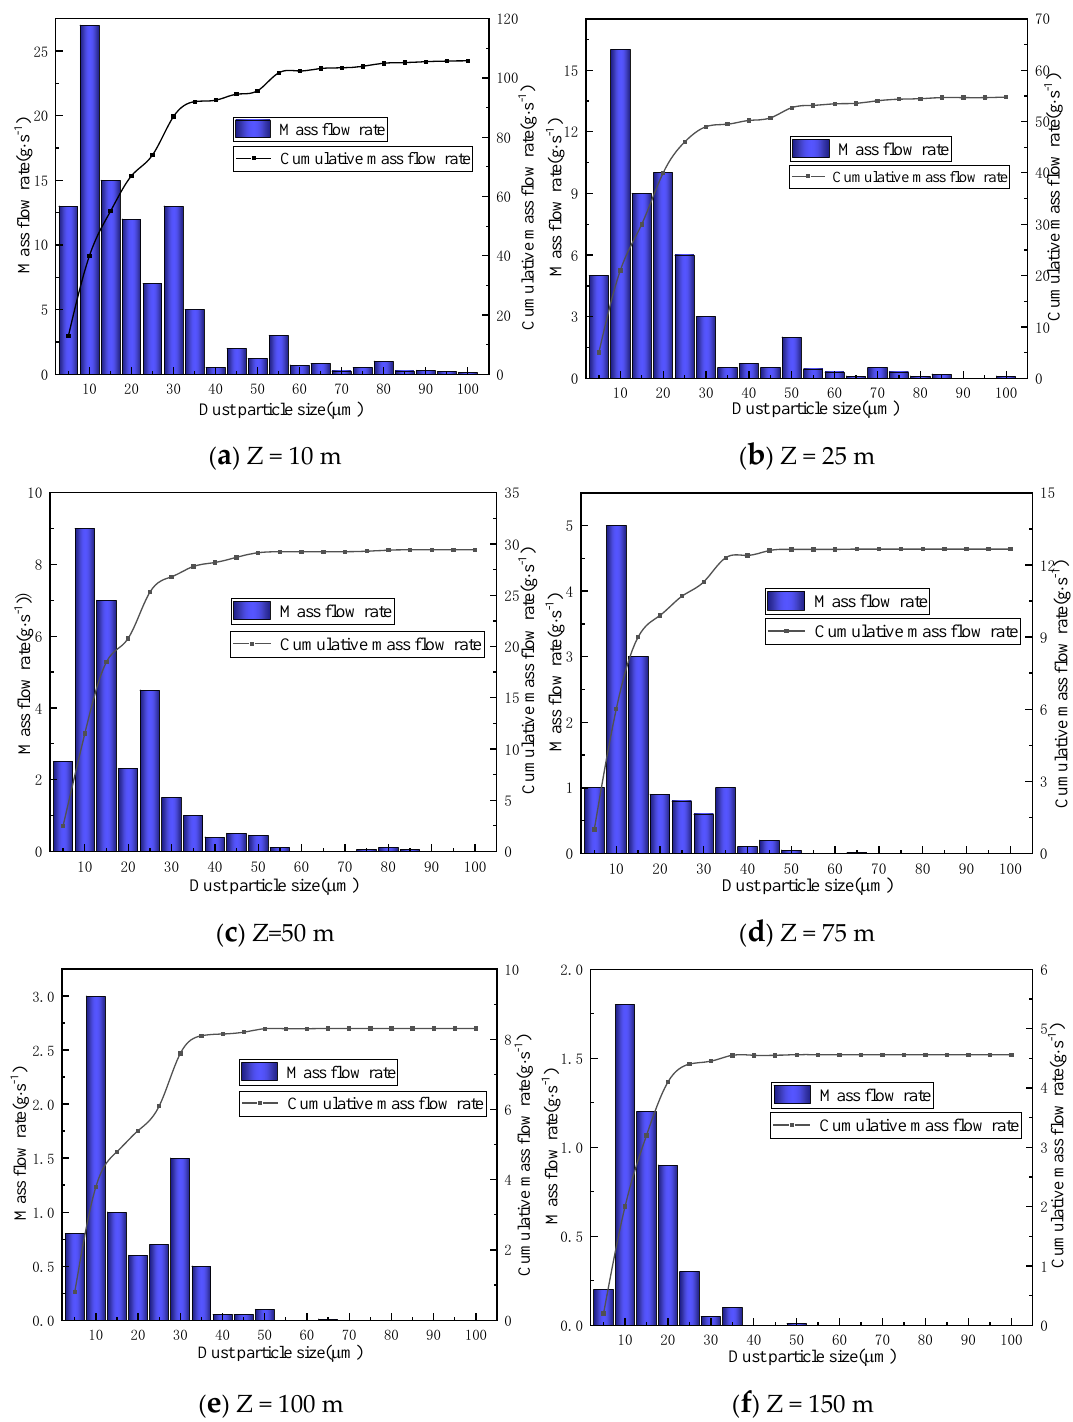
Figure 8. Distribution of the dust particle size at different locations along the tunnel.